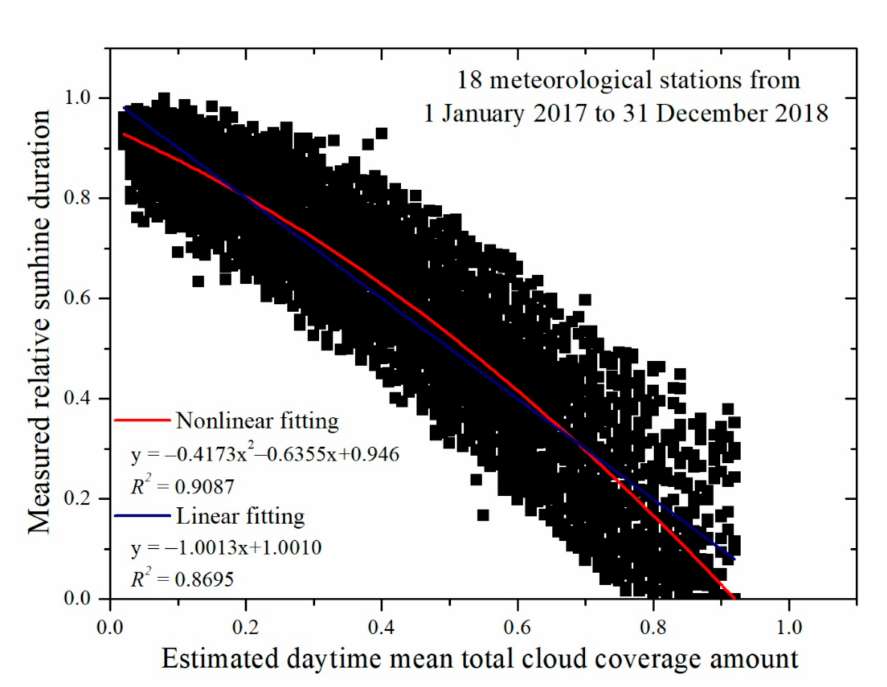
Figure 2. Relationship between estimated daytime mean total cloud coverage amount and measured relative sunshine duration for 18 meteorological stations from 1 January 2017 to 31 December